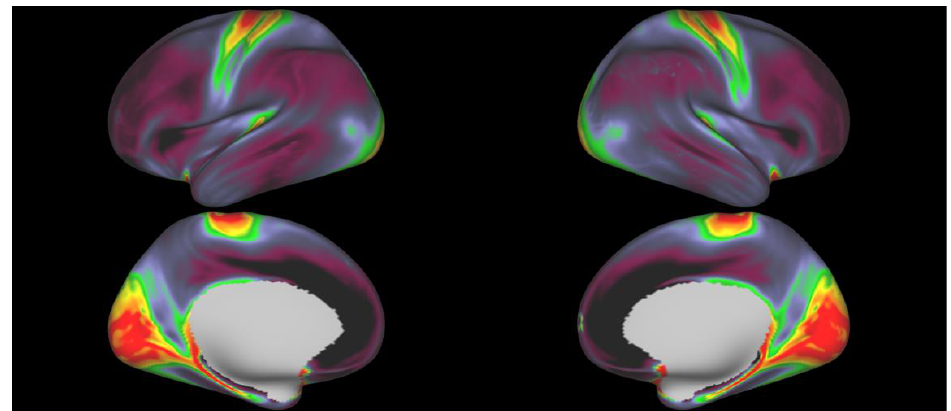
Figure 1. Sample’s ( N = 960) average T1w/T2w ratio map, projected onto its average inflated surface. Warm colors are higher, cool areas lower in myelin.